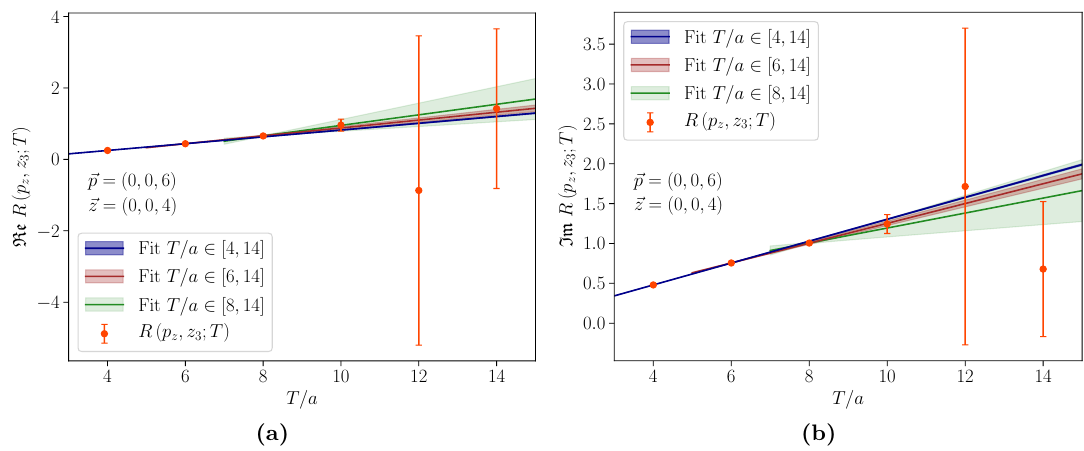
Figure 3. (a) Real and (b) imaginary summation data R ( p 3 , z 3 ; T ) for p 3 ’ 2 . 47 GeV and z/a = 4 , together with the linear fit (3.11) applied for different time series. The slope of each linear fit yields the bare matrix element. Slight tension in the extracted matrix element is observed as the fitting window is altered. Although minor, this stems jointly from the lack of constraint provided by the T/a = 12 , 14 data and the greater flexibility afforded to each fit as the minimum T/a is increased.